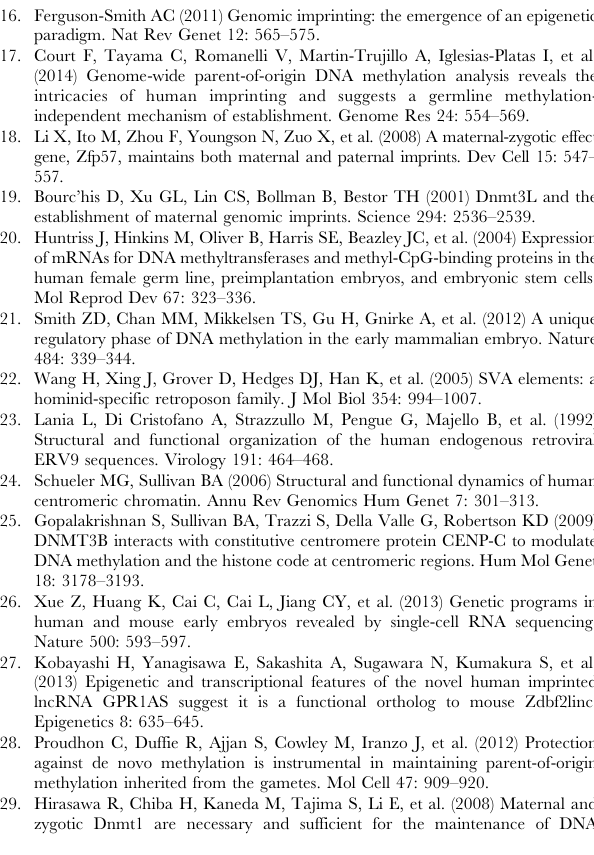
residues, respectively. The percentages of methylated CpG sites are indicated. (TIF) S5 Figure Relationships between methylation levels and CpG densities. Mean methylation levels of CpGs in six repeat families are plotted against CpG densities. All genomic CpGs were also analyzed for comparison. Mean methylation levels were calculated only for CpG densities with . 1000 CpG sites covered by all samples. Transposable elements were essentially highly methylated in ES and blood cells. Low methylation levels of CpGs were observed in oocytes and blastocysts regardless of the CpG density. In sperm, CpGs in SINEs, LTRs and satellites showed especially low methylation levels at high CpG densities. (TIF) S1 Table DNA methylation levels of imprinted DMRs. DMRs are classified into four groups: Maternal gDMRs; oocyte- specific methylated gDMRs with 35–65% methylation levels in blood cells, Paternal gDMRs; sperm-specific methylated gDMRs with 35–65% methylation levels in blood cells, Placenta-specific maternal gDMRs; maternal gDMRs main- tained only in the placenta, Secondary DMRs; DMRs other than gDMRs. For secondary DMRs, neighboring gDMRs are indicated. While the ZC3H12C and LIN28B DMRs are classified as secondary DMRs, these may be placenta-specific maternal gDMRs (the methylation levels in oocytes were 76.0% and 77.4%, respectively). (XLSX)